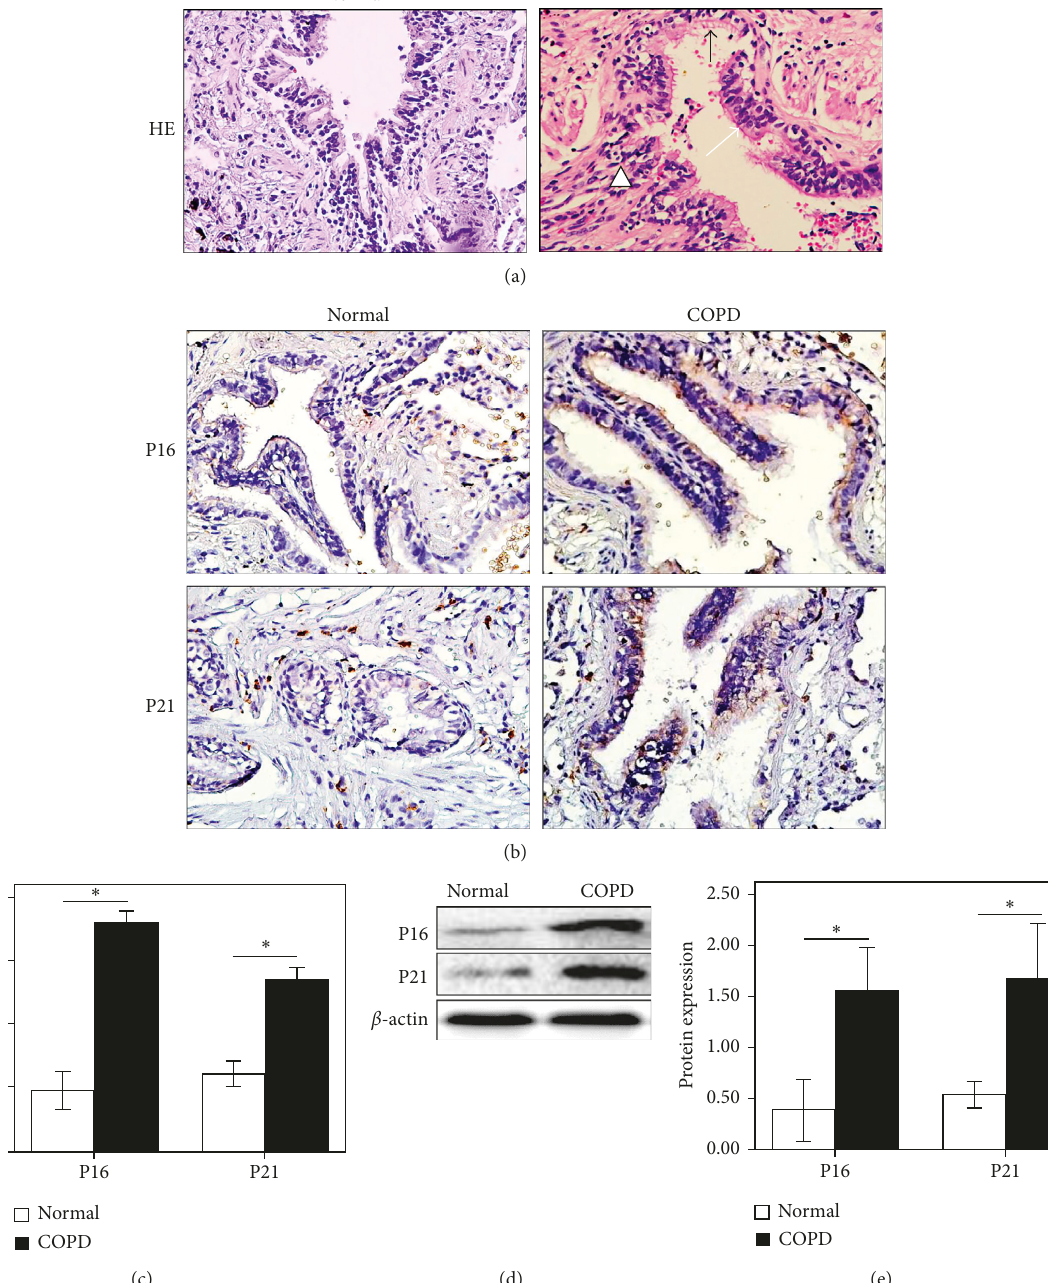
Figure 1: The production of P16 and P21 in the airway epithelium of COPD patients. (a) Micrographs of histological sections of the COPD patients’ airway showed the loss of epithelial integrity, apparent deciduous epithelial cells (black arrow), cilia lodging (white arrow), and submucosal and bronchial surrounding fibrous tissue hyperplasia (triangle) by HE staining (HE, 400x). (b) The expression of P16 and P21 in the airway epithelium of patients with COPD and control subjects were detected by IHC (200x). (c) Semiquantitative analysis of P16 and P21 expression in COPD and control groups was conducted by the optical density (OD). (d, e) The expression of P16 and P21 in the airway epithelium of patients with COPD and control subjects were determined by western